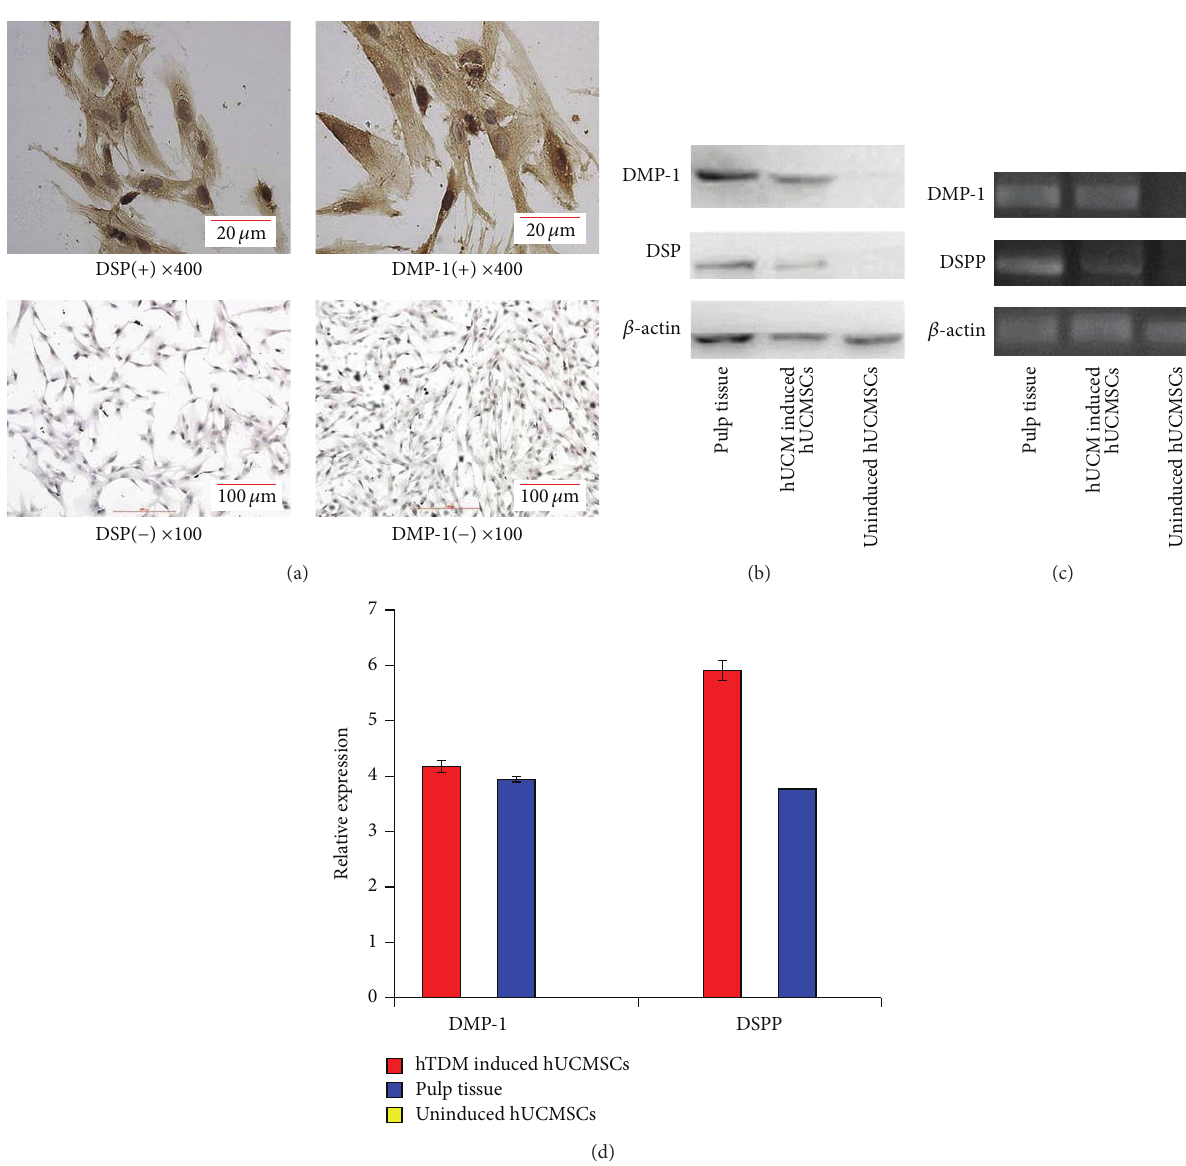
Figure 4: hTDM induces hUCMSCs into odontoblast-like cells in vitro . (a) Detection of DSP and DMP-1 in hTDM-induced hUCMSCs and normal cultured hUCMSCs without hTDM by immunocytochemistry. (b) Western blotting showed that hTDM-induced hUCMSCs and pulp tissue expressed DSP and DMP-1, while uninduced hUCMSCs did not express these proteins. (c) and (d) Relative mRNA levels of DMP-1 and DSPP were determined by quantitative